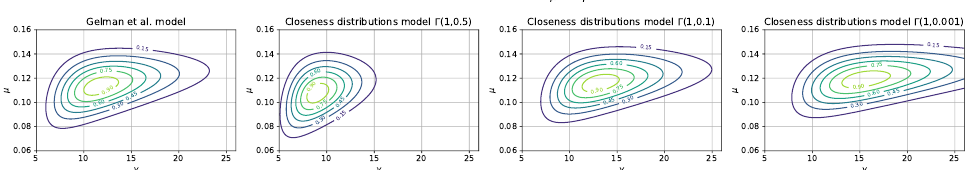
Figure 6. Comparison of posteriors between a closeness distribution model and that proposed by Gelman et al. in